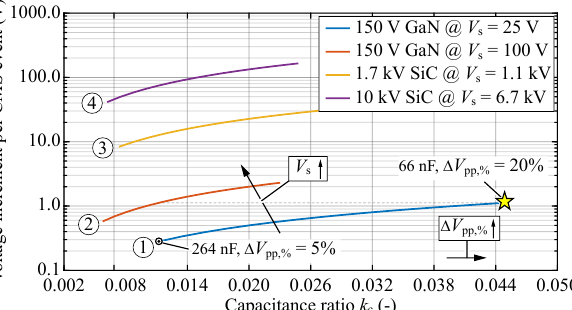
Figure A1. Absolute voltage increment per CMS event ( ∆ V CMS ) for semiconductors of various voltage classes as functions of the capacitance ratio k c = 2 C Q,eq / C FC for the considered relative peak-to-peak FC voltage ripple range ∆ V pp,% = ∆ V pp / V s ∈ [ 5%,20% ]